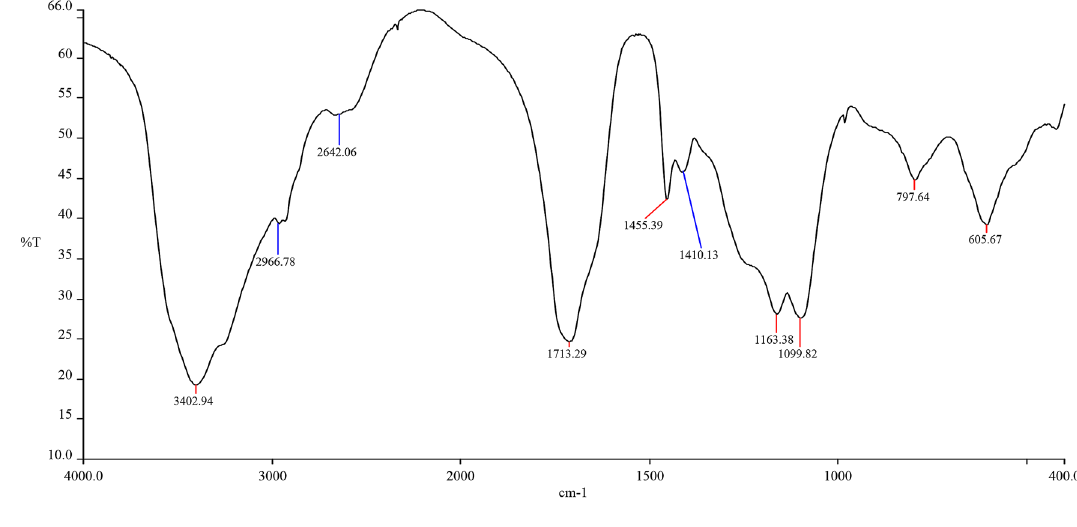
Figure 7. IR Figure.